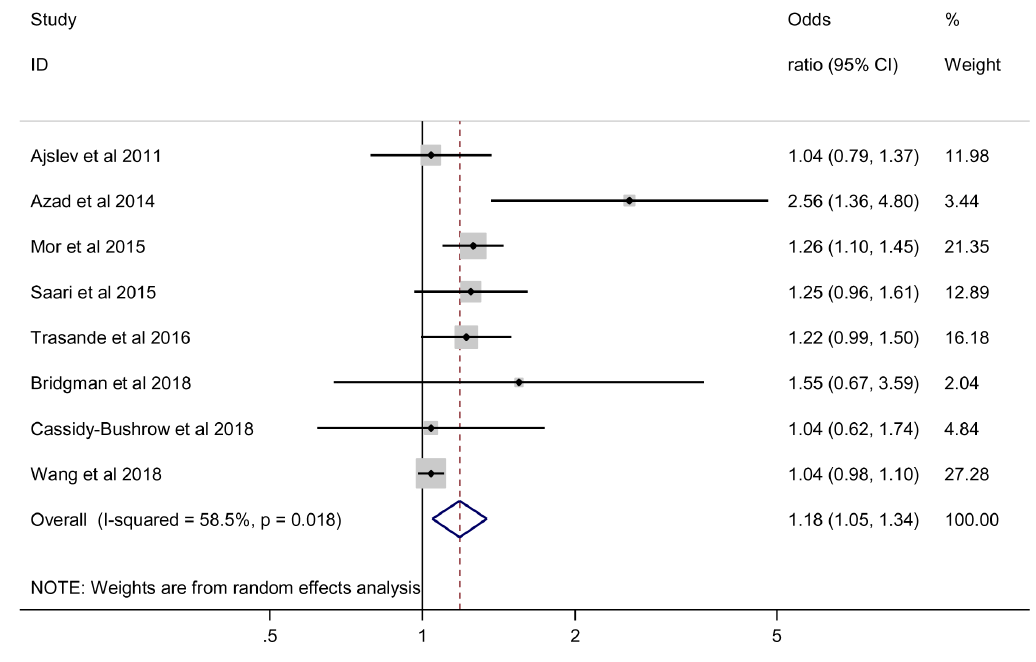
Figure 7. Overweight outcome, sensitivity analysis by risk of bias.